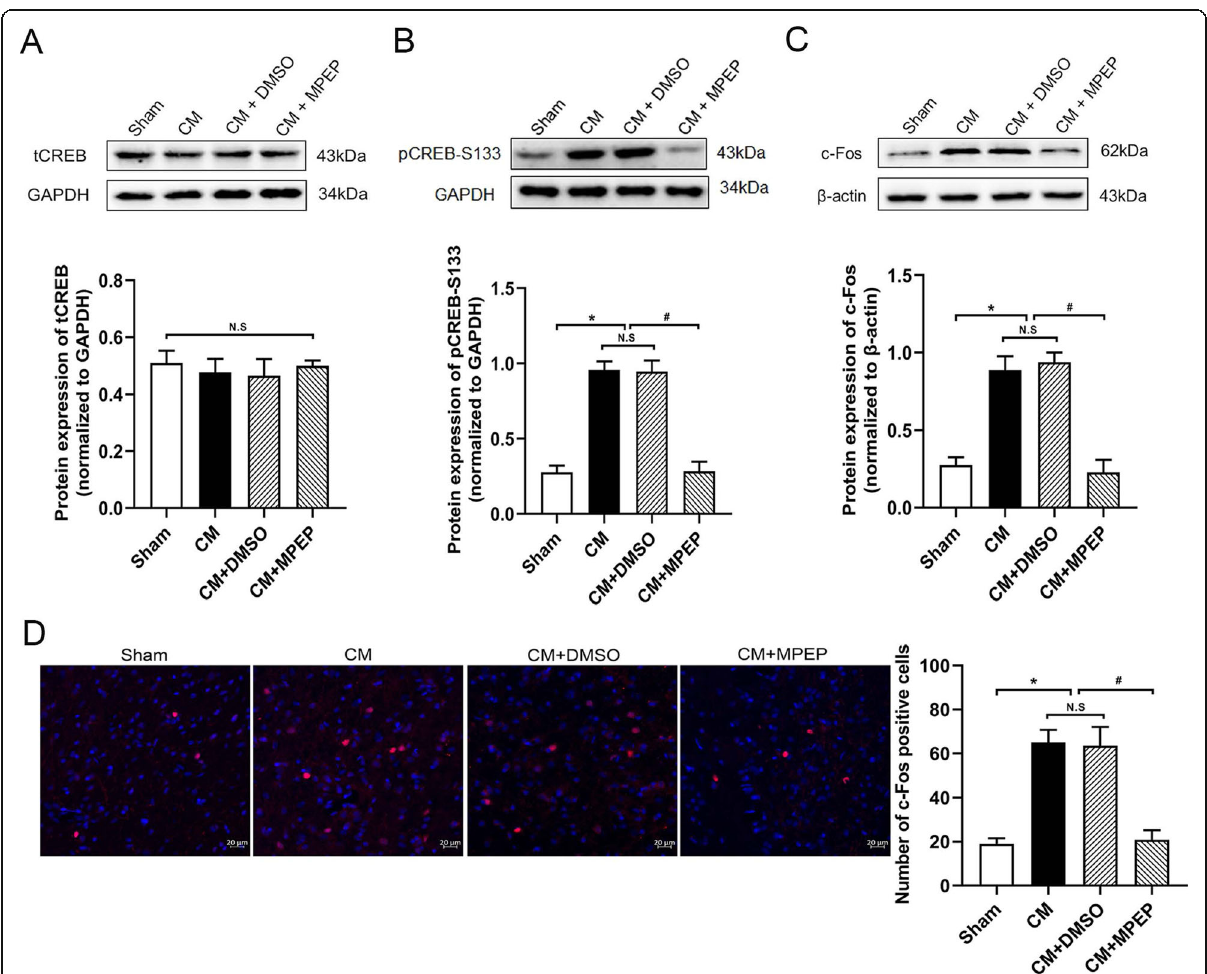
Fig. 8 The effect of MPEP on the expression of p-CREB-S133 and c-Fos. Compared with the sham group, the expression of p-CREB-S133 and c-Fos increased in the CM group. There were no significant differences between the CM and CM+DMSO groups. The administration of MPEP significantly downregulated their expression. a The protein expression of CREB. b The protein expression of p-CREB-S133. c The protein expression of c-Fos. d Immunoreactivity for c-Fos. (n=4 in each group, scale bar=20 μ m; *p<0.05 compared with the sham group; # p <0.05 compared with the CM+ DMSO group; N. S:p>0.05 between two